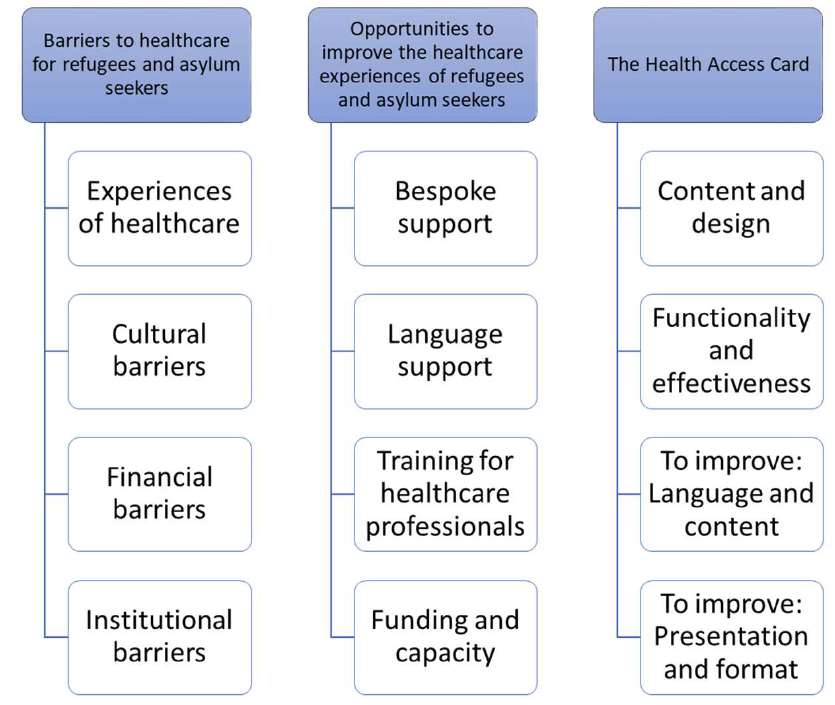
Figure 1. Themes and subthemes from interviews with service users and professionals around the Health Access Card .